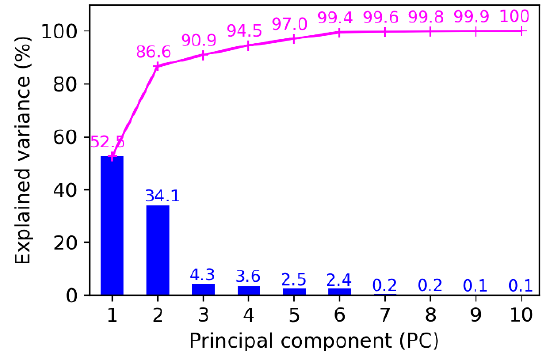
Figure 2. Bar diagram of explained variance versus PCs, and line diagram of cumulative variance of the groups of PCs for the Vaihingen test data